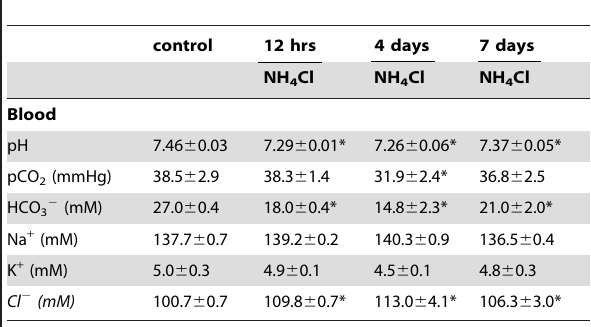
Table 1. Arterial blood data group 1